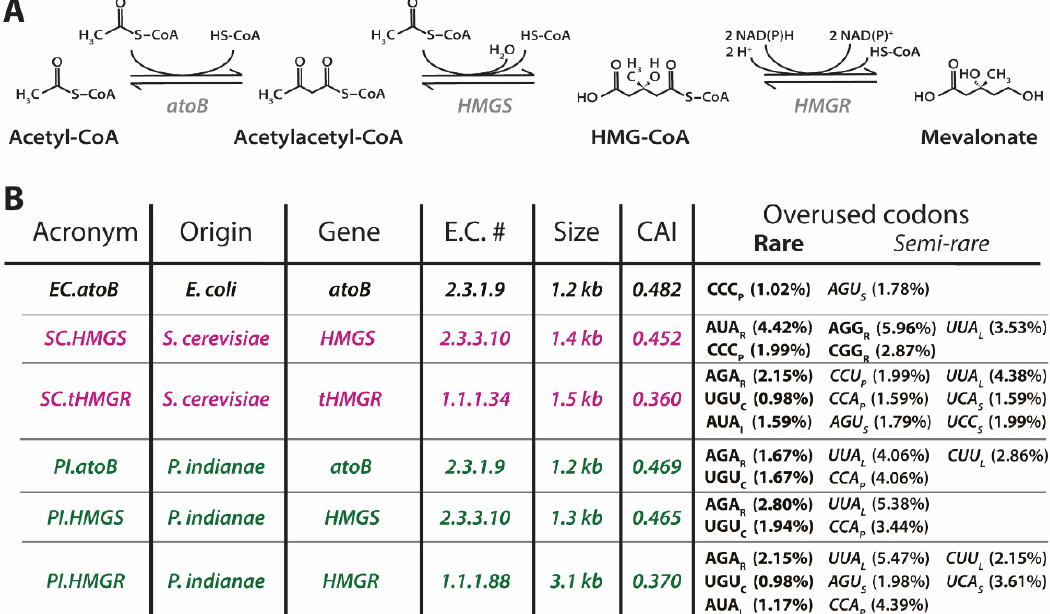
Figure 3. Mevalonate pathway and gene information. ( A ) Mevalonate biosynthesis pathway showing genes, cofactors, and substrate. ( B ) Homolog information for the genes evaluated in this study. Overused codons are used 2-fold or more in these genes compared to the host utilization. Rare and semi-rare codons are used 0.5% and 1.0% of the time or less, respectively. Overall codon usage of each gene is shown next to the codon. Gene names: acetyl-CoA acetyltransferase ( atoB ), HMG-CoA synthase ( HMGS ), and HMG-CoA reductase ( HMGR ).